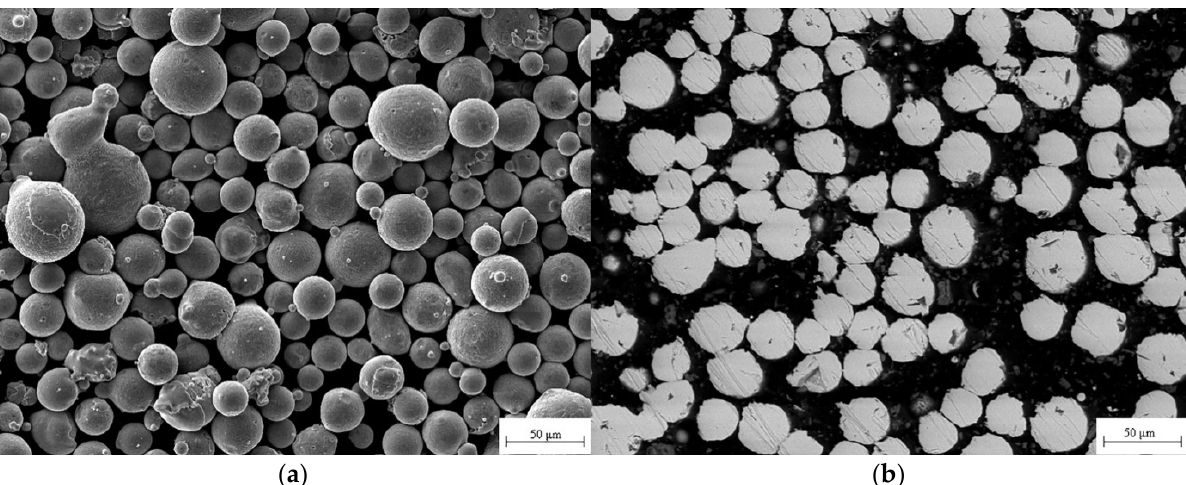
Figure 1. Microstructure of CoCrFeNiMn powder: ( a ) global morphology, ( b ) cross-sectional microstructure.